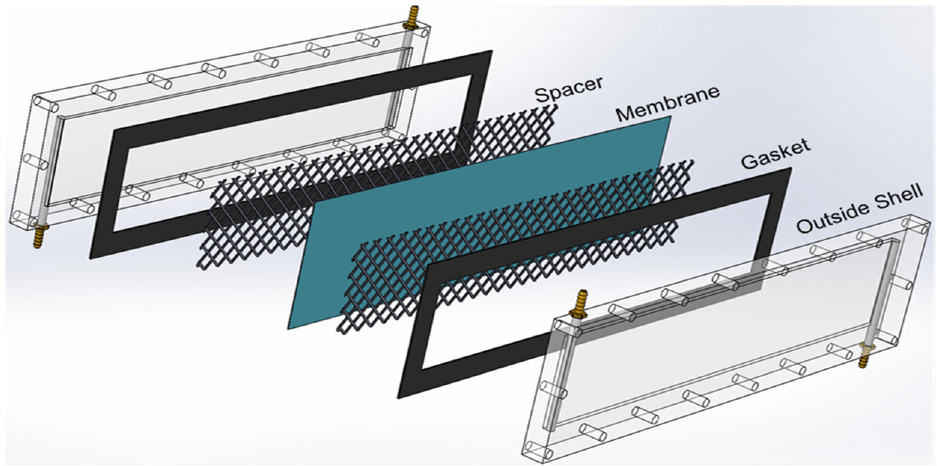
Figure 6. The 3D structural arrangement of the DCMD module.